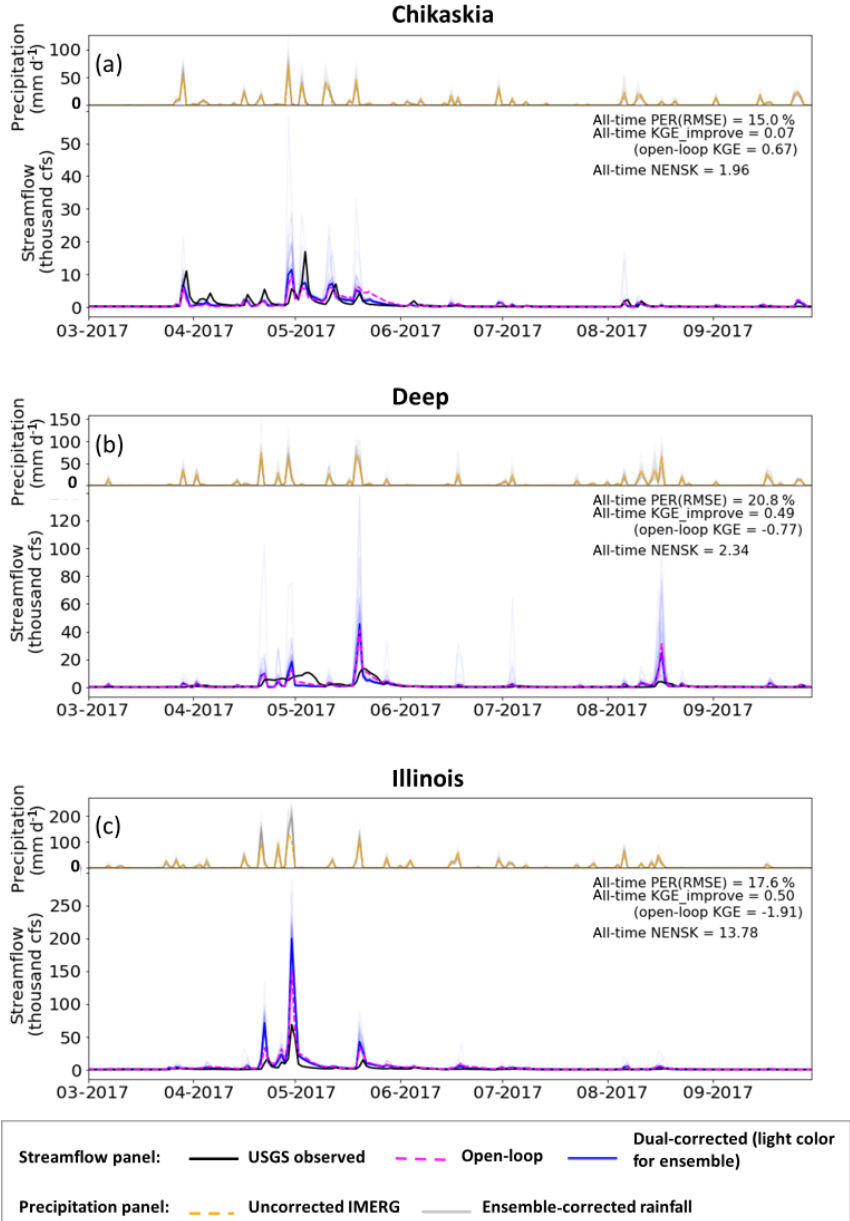
Figure 6. Example time series of streamflow results from the dual-correction system. In the upper part of each panel, orange line: uncorrected IMERG rainfall aggregated to the sub-basin-average; light-grey lines: ensemble-corrected rainfall. Only part of the simulation period is shown for clear display; however, statistics shown on each panel are based on the entire simulation period (approximately 2.5 years). In the lower part of each panel, black line: USGS observed streamflow; magenta line: baseline VIC simulation; light-blue lines: ensemble-updated streamflow results; solid blue line: ensemble-mean-updated streamflow; cfs: cubic feet per second (0.0283m 3 s − 1